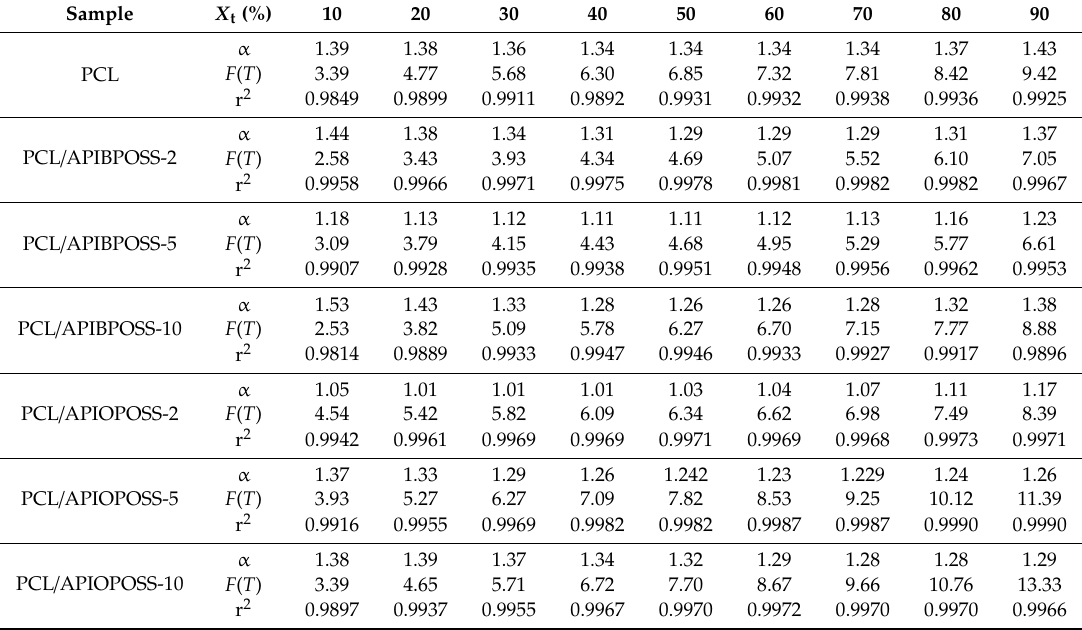
Table 3. The non-isothermal crystallization kinetic parameters based on Mo model for PCL and PCL / POSS